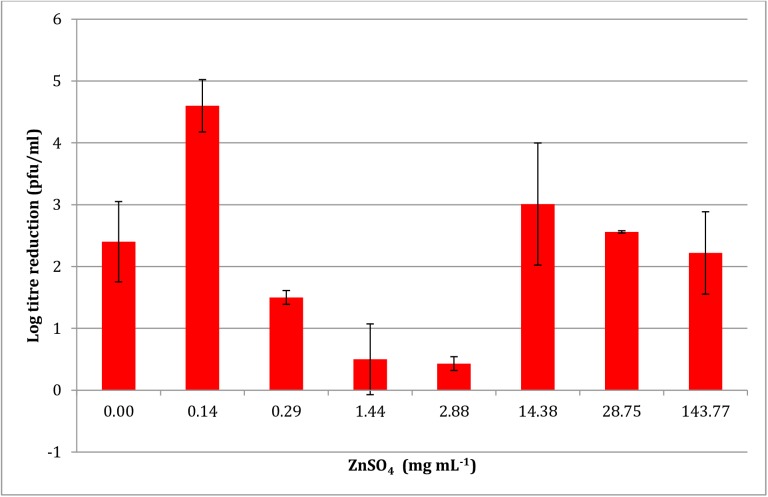
Effect of ZnSO4 concentrations on the potentiated virucidal activity of punicalagin (0.01 mg mL-1) (n = 4 ± SD).Results show a maximum at 1.44 mg mL-1, after which the pattern is unpredictable.